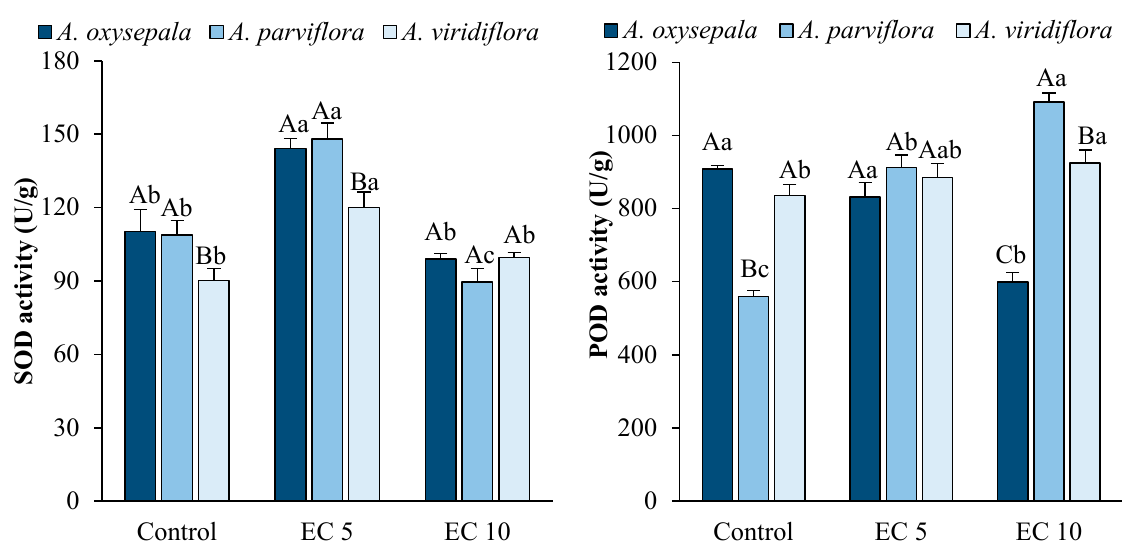
Figure 8. The antioxidant enzyme activity changes in A. oxysepala , A. parviflora , and A. viridiflora irrigated with tap water (control) and salt solution at an electrical conductivity (EC) of 5 dS · m − 1 (EC 5) and 10 dS · m − 1 (EC 10). According to Tukey’s variance and analysis at p < 0.05, means with the same uppercase letters are not significantly changed among different species under the same treatment, and means with the same lowercase letters are not significantly changed among different treatments in the same species. Vertical bars represent standard error (SE).